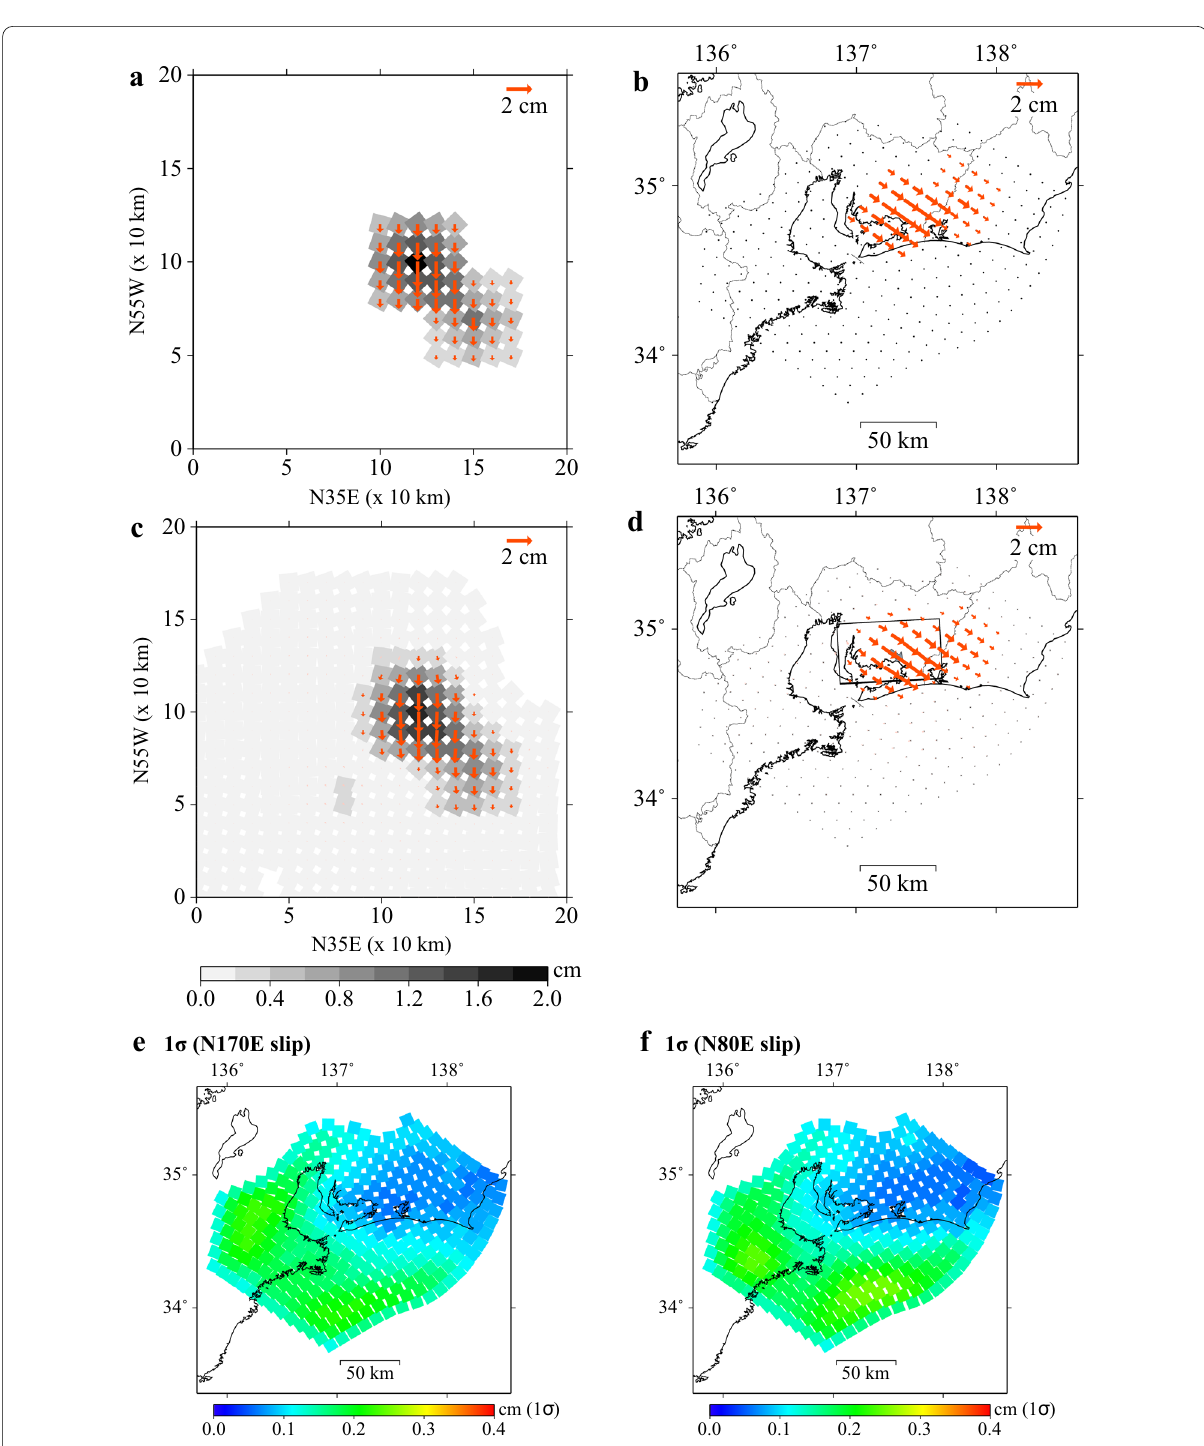
Fig. 3 Test of the proposed method using synthetic strain and tilt datasets. a Given slip distribution. b Surface projection of the given slip distribution. Dots indicate the location of subfaults. c Retrieved slip distribution. d Surface projection of the retrieved slip distribution (arrows) and a rectangular fault model (rectangle and gray arrow). Slips exceeding the standard deviation (1 σ ) are shown in red and slips below the 1 σ are shown in light pink. Map region corresponds to Area A in Fig. 1. e , f Distribution of the standard deviation (1 σ ) of the estimated slip in the direction of N170E ( e ) and N80E ( f ) at each